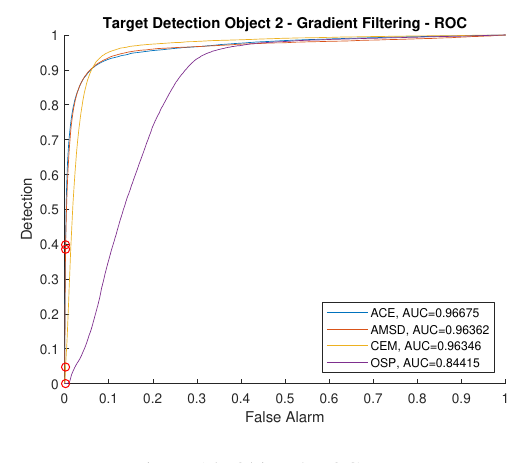
Figure 14. Object 2